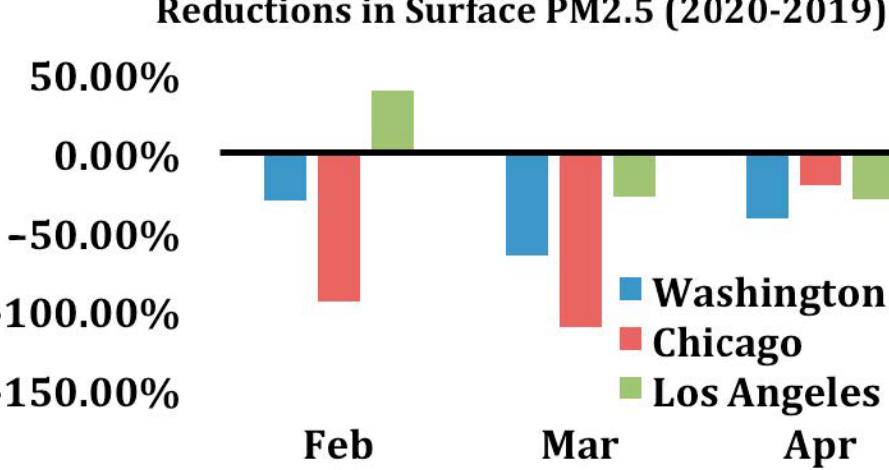
Figure 17. Distribution of surface PM 2.5 in Washington, DC, Chicago, and LA during February– March.